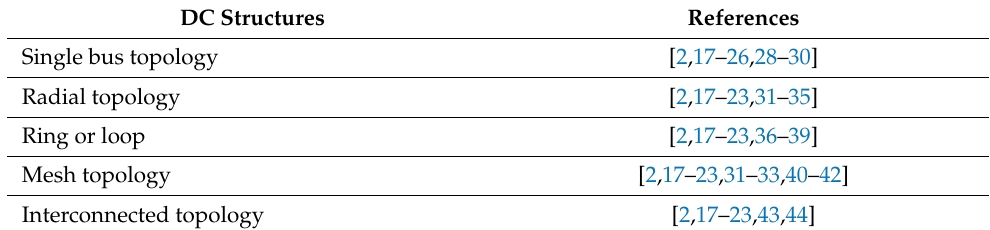
Table 1. Summary of the DC microgrid topologies and corresponding references. DC Structures